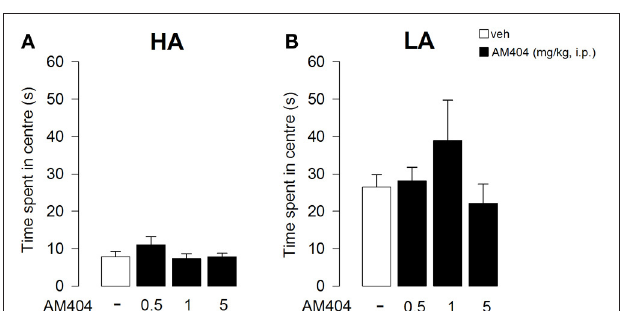
FIGURE 5 | Effects of AM404 administration on emotional behavior in rats exposed to high arousal (HA) or low arousal (LA) conditions. Time spent in the center of the arena by rats exposed to HA (A) or LA conditions (B) in session 1. Data are expressed as mean ± SEM. (HA: veh n = 10,